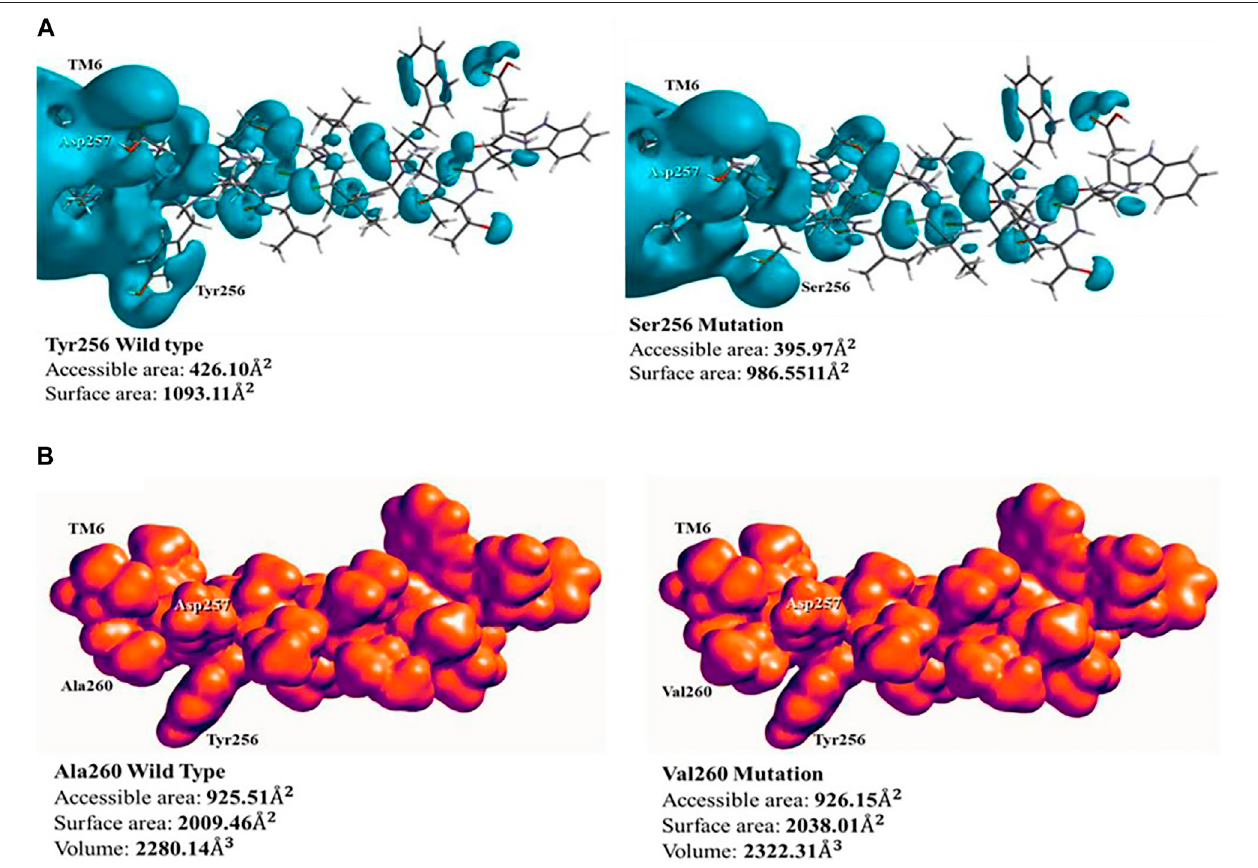
FIGURE 4 | Surface representation of electronic structure of PS1 Tyr256Ser and Ala260Val mutations: (A) the potential – potential surface of wild type (left) and mutation Tyr256Ser (right) . Modi fi cation of the surface corresponding to position 256 can be observed; (B) density surface of wild type (left) and mutation Ala260Val (right) , showing the increment in charges volume, blocking potential access to Asp257. The space around Tyr256 is used as a point of